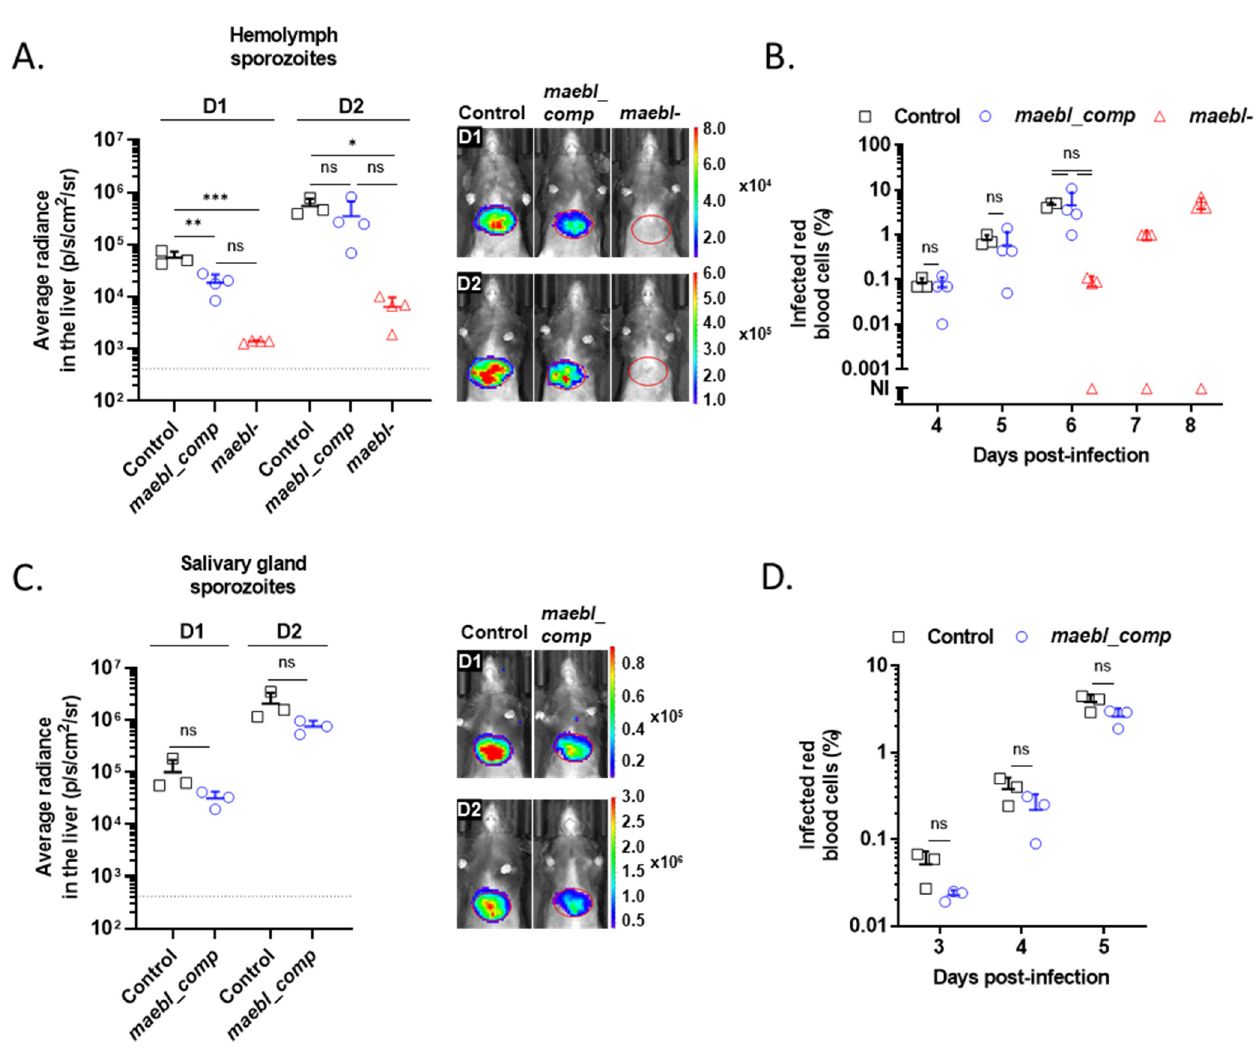
Figure 2. Infectivity of maebl - and maebl_comp sporozoites to mice. ( A–D ) Infectivity of maebl - and maebl_comp sporozoites to C57BL/6 mice. Mice were injected intravenously with 3.5 × 10 4 Control, maebl- and maebl_comp hemolymph sporozoites (panels A-B) or with 2.5 × 10 4 Control and maebl_comp salivary gland sporozoites (panels C-D), collected from mosquitoes on days 20 or 21 post-infection. ( A , C ) Left: parasite burdens in the liver were quantified as average radiance (photons/s/cm 2 /steradian) one (D1) and two (D2) days post-infection. Symbols represent values for individual animals and bars indicate the mean + SD ( n = 3–4). Dotted line: background level, calculated using non-infected mice. Statistical analysis was performed using one-way ANOVA (Tukey’s multiple comparisons test; panel ( A ) or unpaired t -test (panel C). Right : representative images of infected mice, on D1 and D2 post-infection. ( B , D ) Parasitemia of infected mice, determined daily by a Giemsa-stained blood smear. Symbols represent values for individual animals and bars indicate the mean + SD. Statistical analysis was performed using unpaired t -test ( B , D ) or one-way ANOVA (Tukey’s multiple comparisons test) ( B )]. ns, non-significant; * p < 0.05; ** p < 0.01; *** p < 0.001; NI, non-infected. Genetically complemented maebl - sporozoites successfully enter the mosquito salivary glands (Figure 1A). To assess whether maebl_comp sporozoites have completed their maturation in the vector and efficiently infect the mammalian host, mice were inoculated i.v. with maebl_comp or control sporozoites collected from the mosquito between experimental groups at D1 and D2 (Figure 2C), as well as in the parasitemia of animals (Figure 2D). The maebl- line was not used in these experiments due to its reduced number of salivary glands-associated sporozoites. Therefore, mice were inoculated i.v.